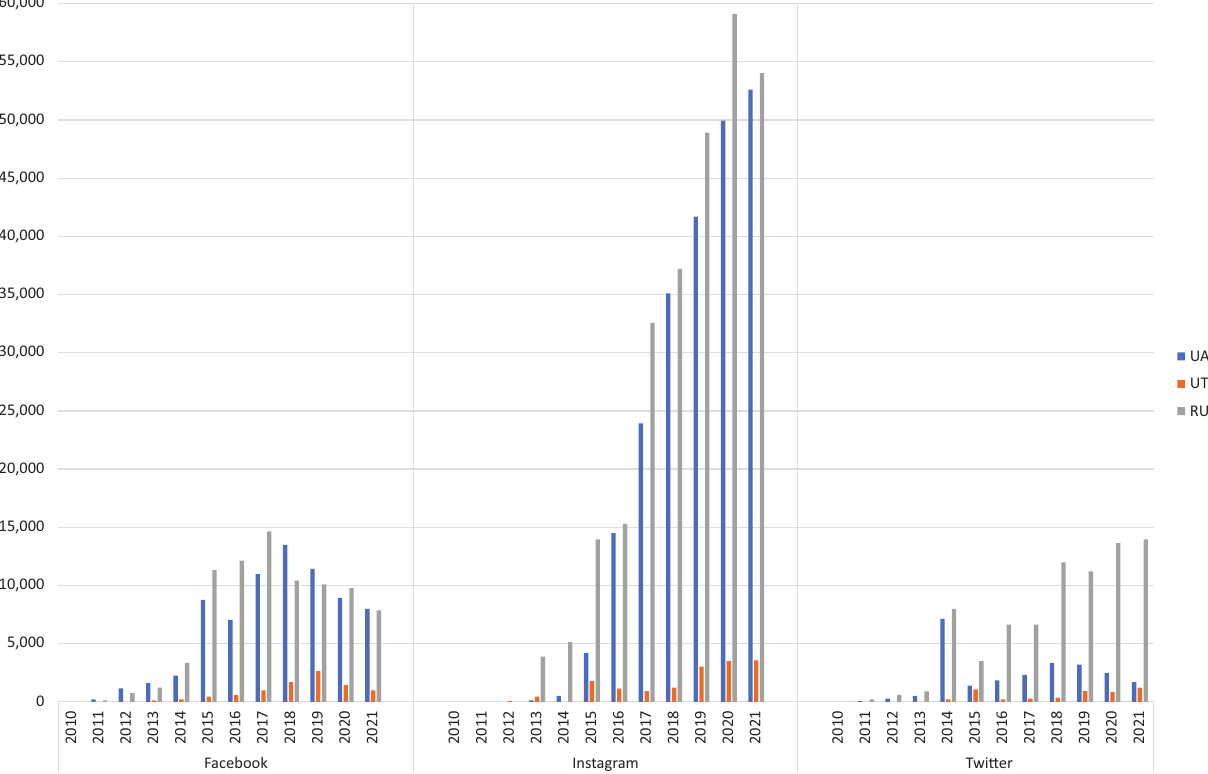
Figure 3. Yearly average number of user reactions to social media posts published by Swiss HEIs on Twitter, Facebook, and Instagram. Note: The mean value ( M ) and the standard deviation ( SD ) were both calculated for each value and are available in Tables I and II in the Supplementary File; UAS = universities of applied sciences; UTE = universities of teacher education; RU = research